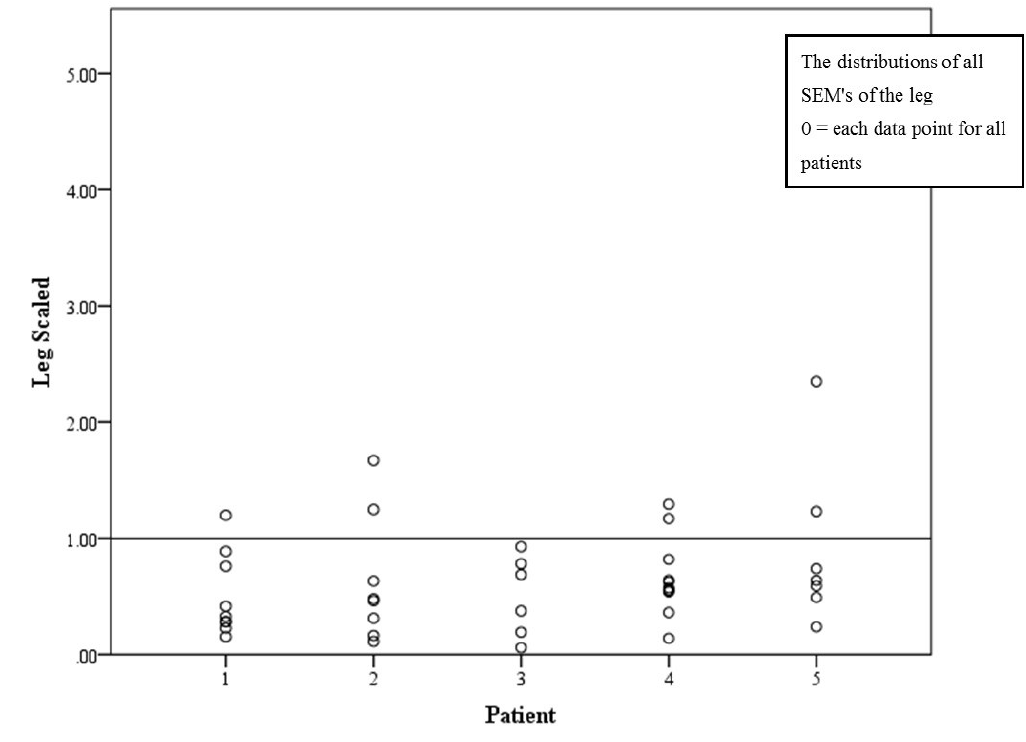
Figure 4. Scaled SEM presented in percentage, with the line at 1%